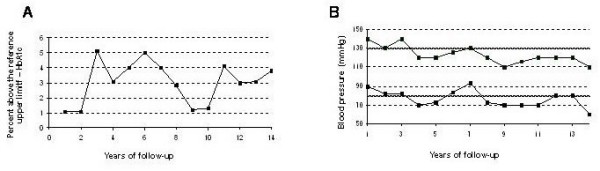
Patient's long-term glycemic and blood pressure control. A. Evolution of the HbA1c test during the years of follow up (in percentage points above the higher limit of the reference). B. Evolution of the control of blood pressure (systolic and diastolic) during the years of follow up compared to the values advocated.